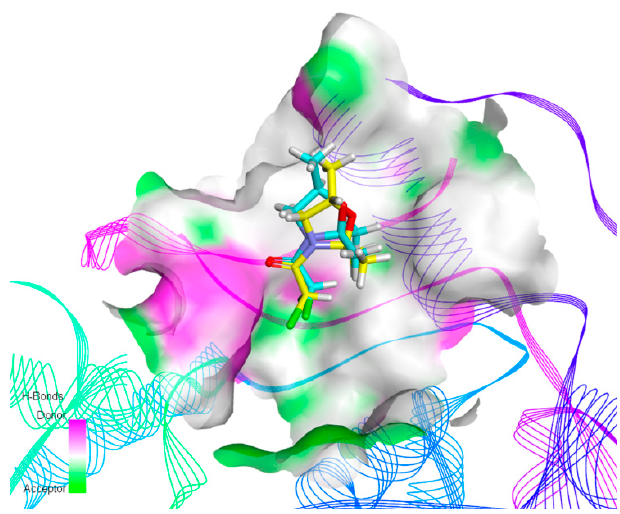
Figure 4. Overlay of the docking model of the two isomers with the ALS active site.